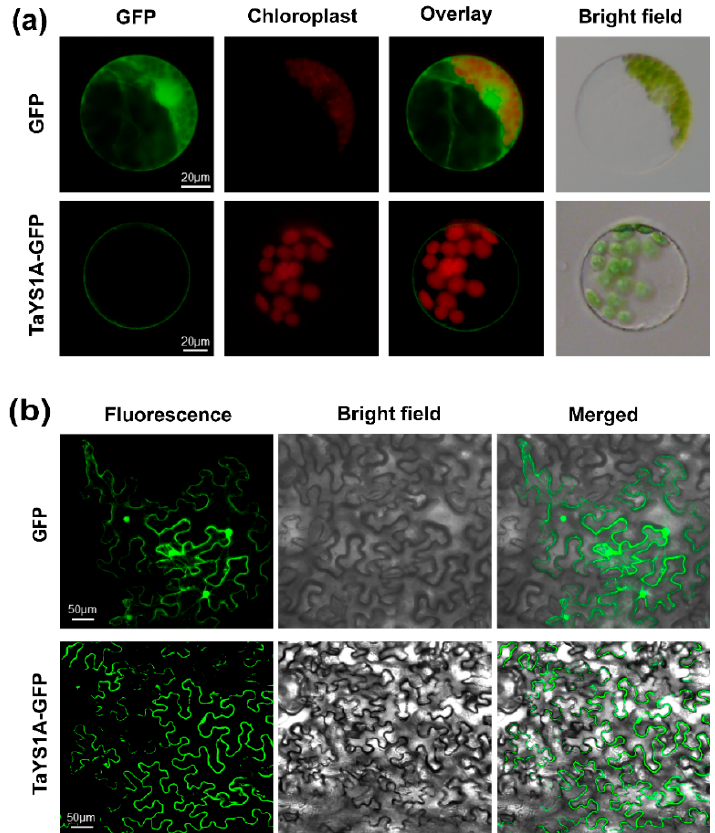
Figure 2. TaYS1A protein subcellular localization assays. ( a ) The PEG-mediated transformation was used to overexpress Green Fluorescent Protein (GFP) or TaYS1A-GFP fused proteins in wheat protoplasts. ( b ) GFP or TaYS1A-GFP construct were transformed into A. tumefaciens and then infiltrated into N. bentamiana leaves. The GFP autofluorescence was imaged using an Olympus FV1000 confocal microscope with a 488 nm filter.